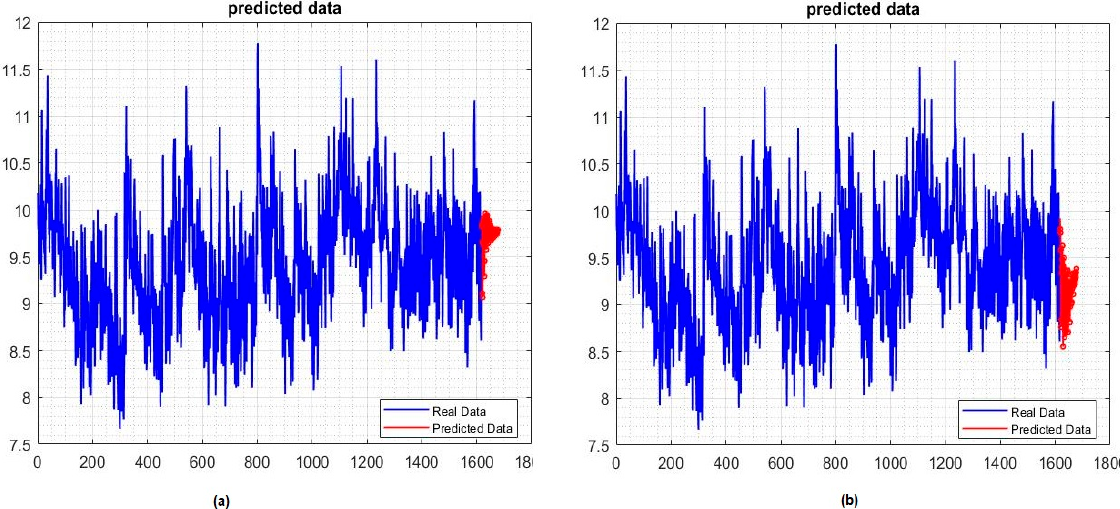
Figure 7. Forecasting future values in time-period of 60 days. ( a ) GRU model and ( b ) MLP model.